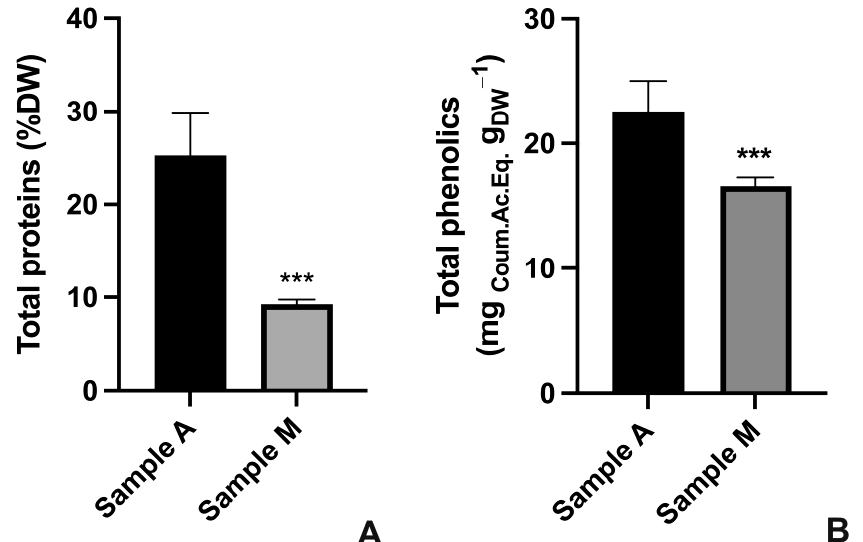
Figure 3. Total protein and total phenolic compounds content in N. oleoabundans autotrophic (A) and mixotrophic (M) cultures at 28 d for culture A and at 12 d for culture M. ( A ) Total protein content expressed as percentage of algal dry biomass (%DW). ( B ) Total phenolic compounds content expressed as mg equivalents of coumaric acid over algal biomass (mg Coum.Ac.Eq. g DW − 1 ). Data refer to means ± standard deviations ( n = 3). Asterisks identify significant differences between cultures A and M: ***, p < 0.001.